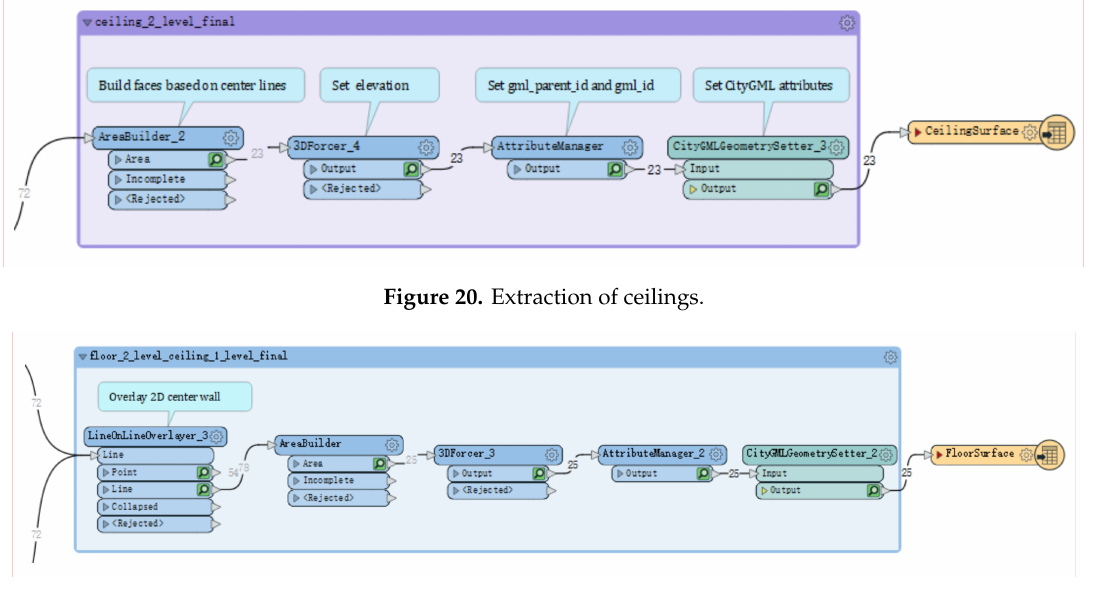
Figure 21. Extraction of